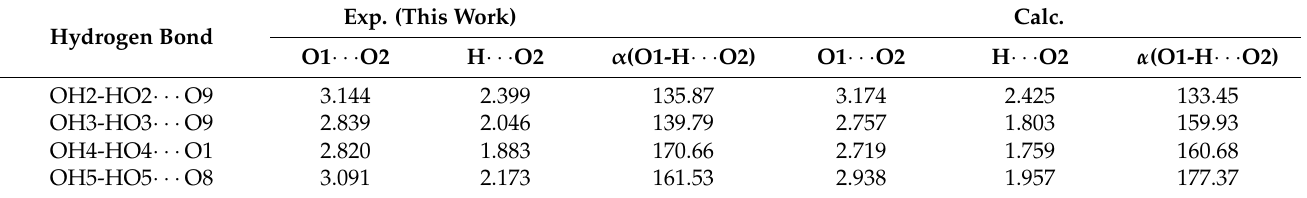
Table 4. Hydrogen bond parameters in derriksite (distances are given in Å and angles in degrees). Hydrogen